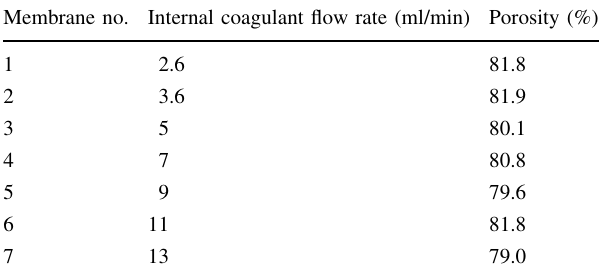
Table 1 Effect of ICFR on porosity of the hollow